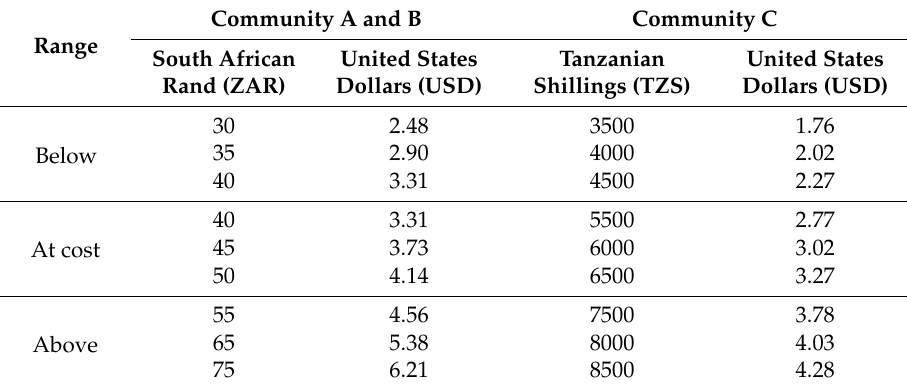
Table 1. The three ranges of prices offered in the willingness-to-pay survey. The ranges are based roughly on the cost of production of the technology. The offered prices were in the local currency and are shown below converted into United States Dollars based on the six month average conversion rate leading up to the survey